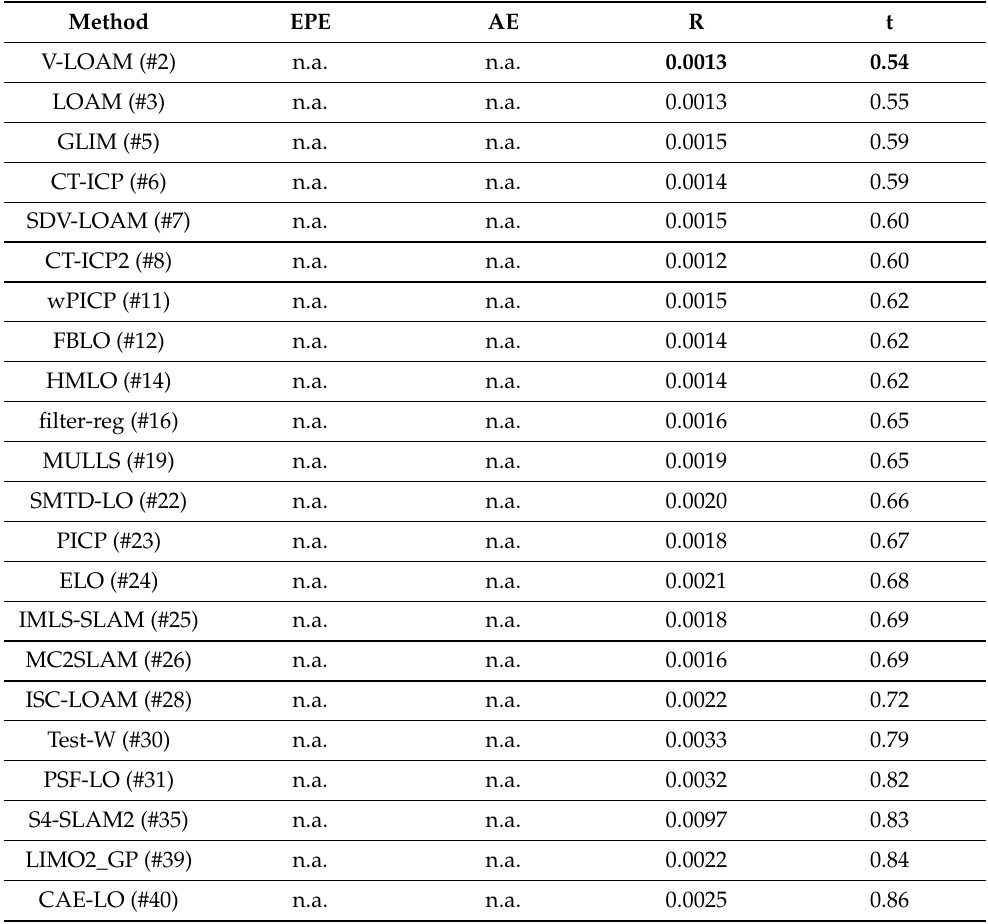
Table 2. Extract of the ranking of the Kitti Odometry dataset showing point cloud based methods. The proposed method would be placed within the ranking, although rather at the end. Nevertheless, this shows the additional applicability of the method to other highly studied